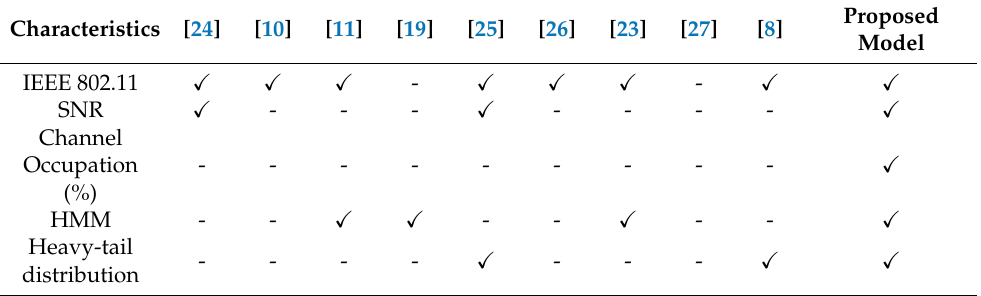
Table 1. Parameters of related works and proposed model.